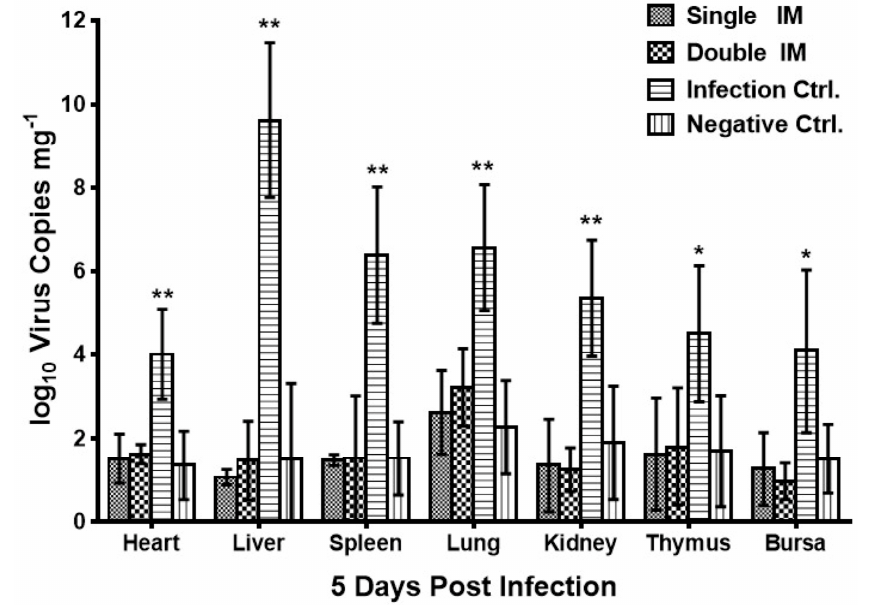
Figure 4. Virus shedding in chickens of different groups at 5 days post infection. Significantly higher levels of virus were detected in different tissues of the chickens in the Infection Ctrl. group. There was no significant difference between chickens in the two immunized groups and the Negative Ctrl. group. Significant differences between different experimental groups were evaluated at (* p < 0.05) or (** p < 0.01).